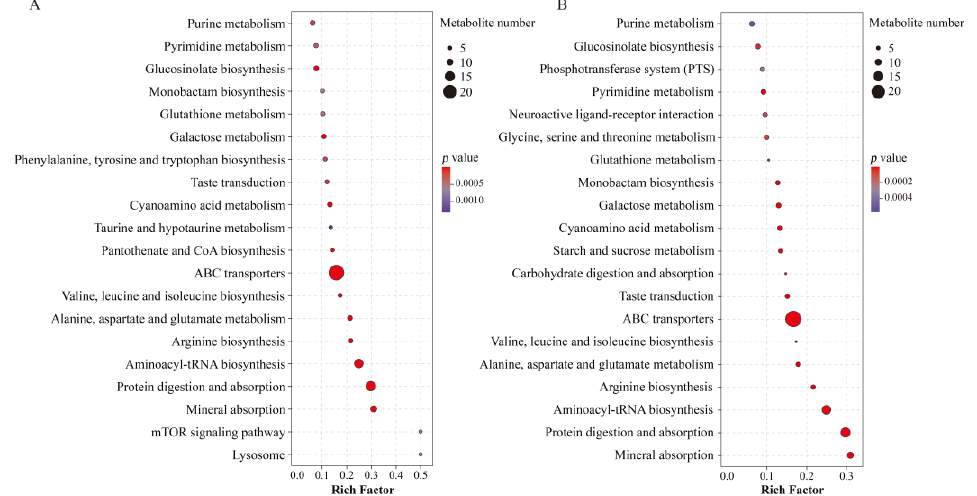
Figure 5. Bubble diagram of metabolic pathway analysis of Porphyra haitanensis in the 0.5 W/m 2 ( A ) and 1 W/m 2 ( B ) UV-B treatments compared with the control. The shade of the dot color indicates the size of p value, which represents the significance of the degree of influence on a certain pathway. The red color indicates that the smaller the p value, the more significant the effect was on the pathway. The purple color means higher p value. A larger area of the point indicates that more differential metabolites were involved in the metabolic pathway. The figure shows the first 20 metabolic pathways in the enrichment metabolic pathway with a p value < 0.05.